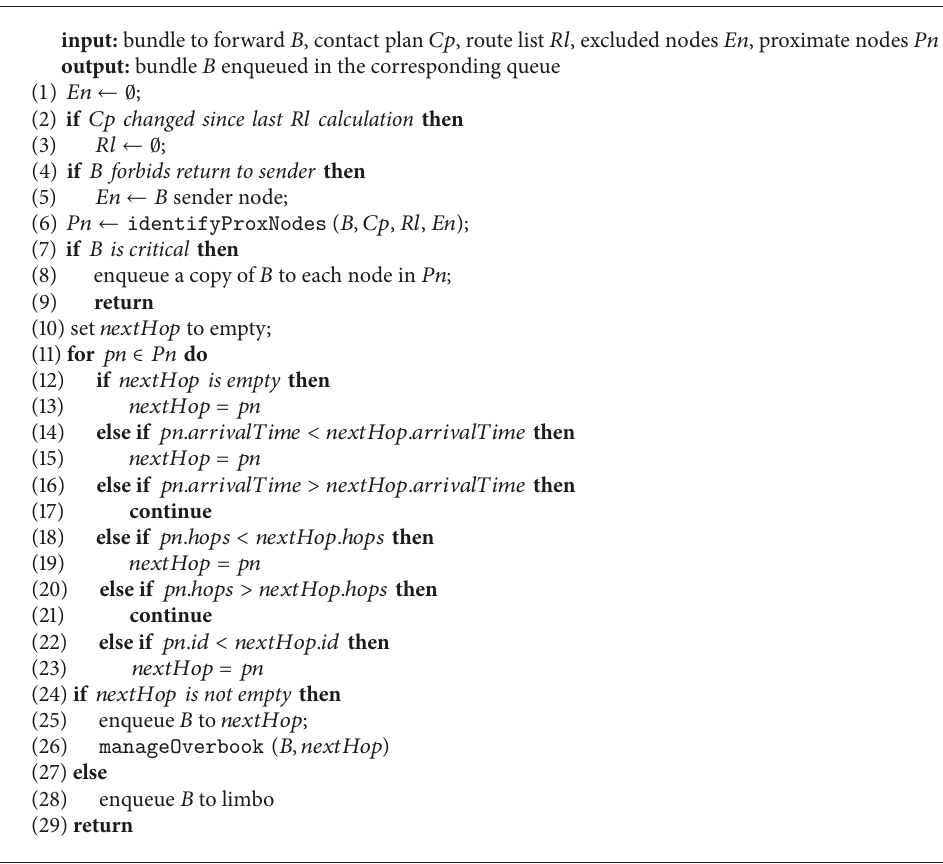
Algorithm 1: best arrival time is considered first and then route hop count. During this process, necessary route